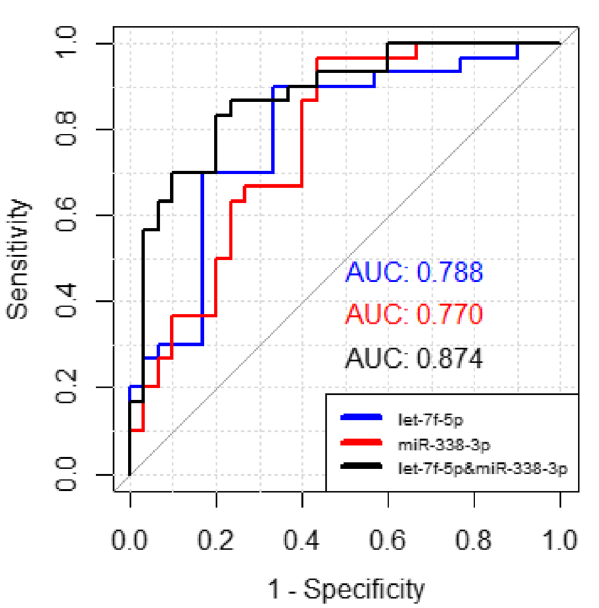
Figure 4. RT-qPCR analysis of miR-451a, let-7f, miR-338 and miR-34a levels in 30 ALS and 30 control. ( a ) The fold change of expression value (2 −∆∆Ct ) of miRNAs in ALS (gray) and control (white) normalized by the mean expression levels (∆Ct) of all controls. The boxplots are showing the median expression in ALS relative to control. ( b ) The CT of expression levels are presented as bar plots showing the error bars of miRNA expression in ALS and control.